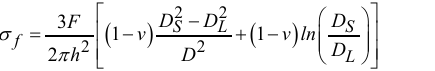
O at concentrations of 0, 5, 2 5